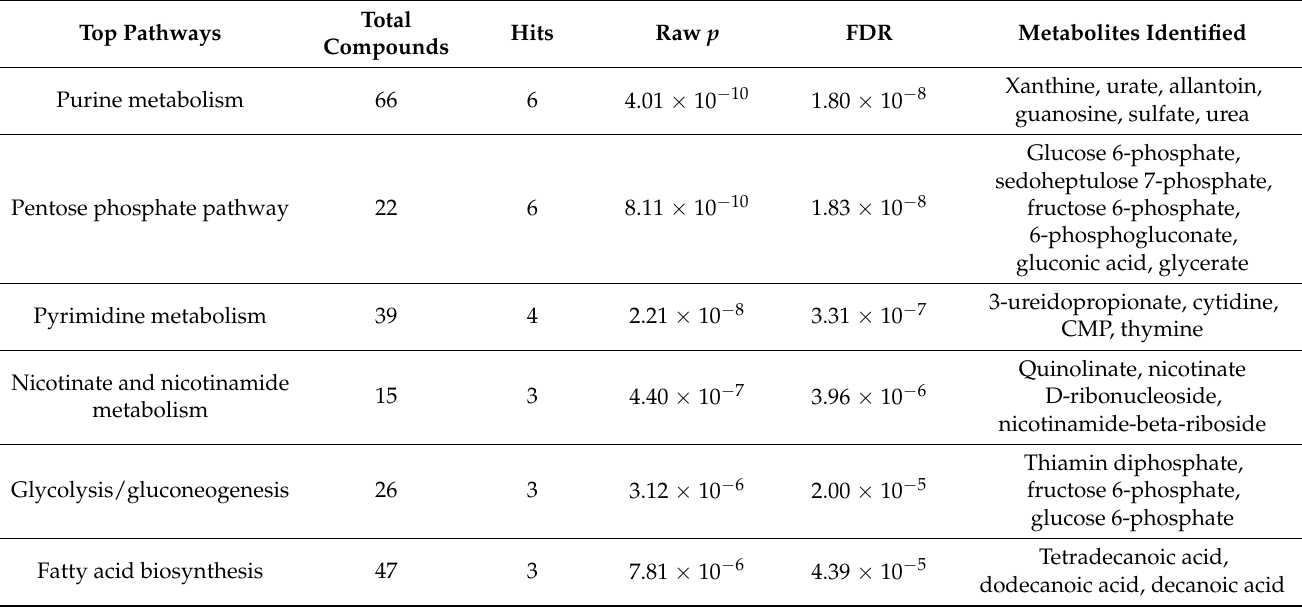
Table 1. Top pathways enriched with metabolites having significantly altered abundance in alcohol- exposed maternal liver, as identified by the pathway analysis using MetaboAnalyst.